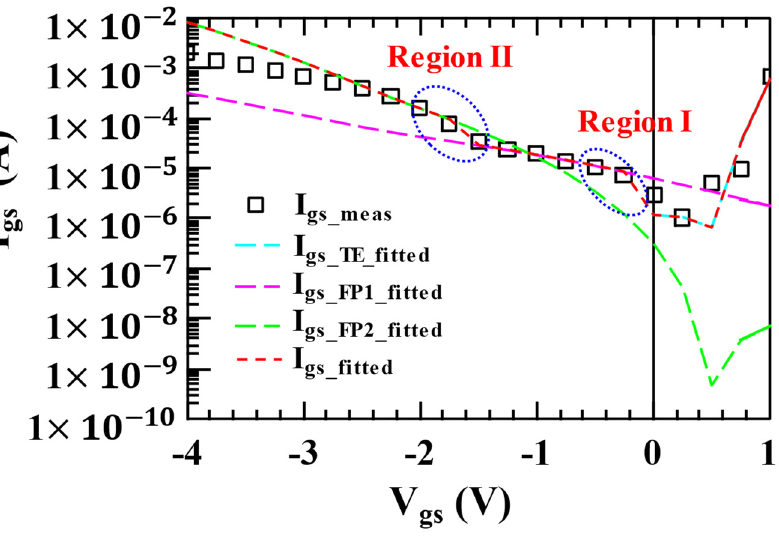
Figure 6. Measured and simulated curves of the gate current of an AlGaN/GaN HEMT as a function of bias voltage at 300 K.